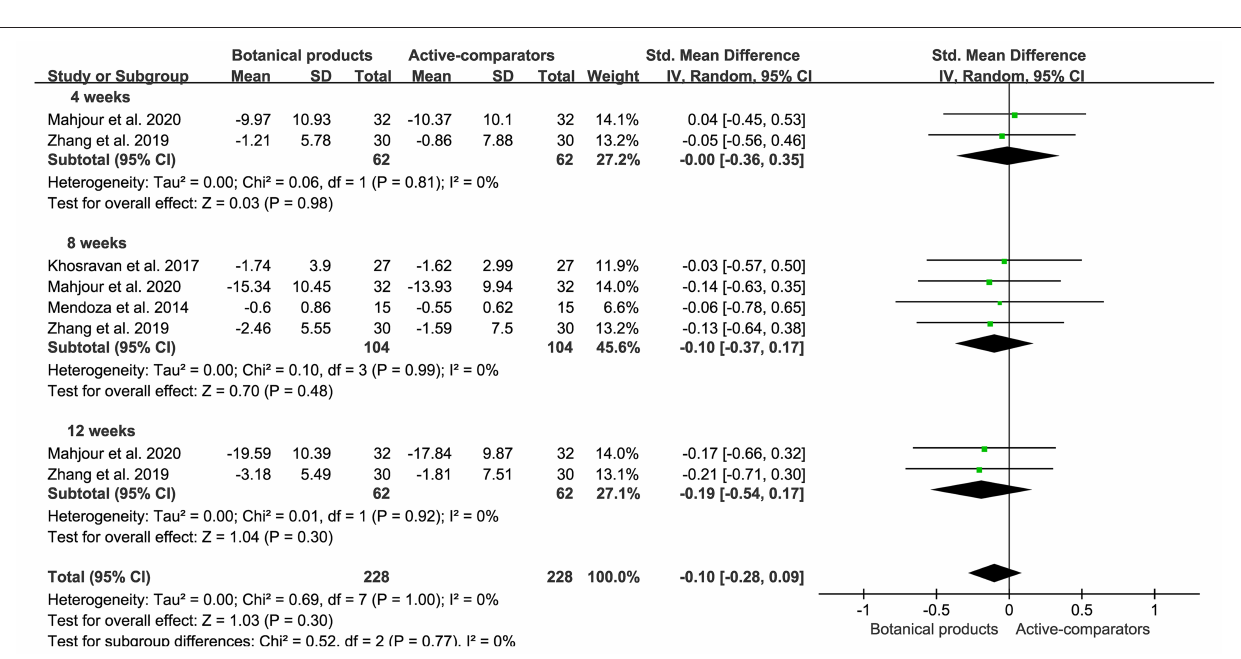
FIGURE 5 | Forest plots depicting the SMD of MASI reduction in patients with melasma receiving botanical products in active-controlled trials. Subgroup analysis was stratified according to the duration of the